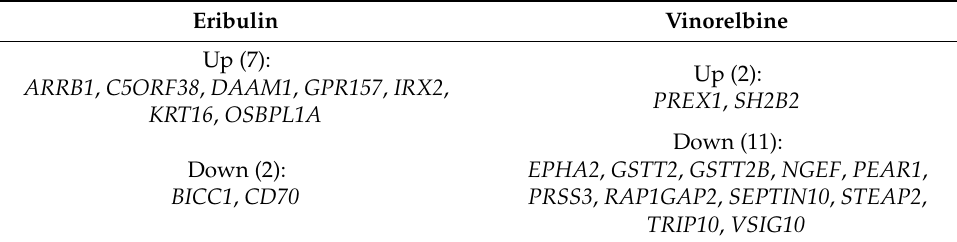
Table 2. Unique fingerprint genes (UFGs) associated with drug response 1,2,3